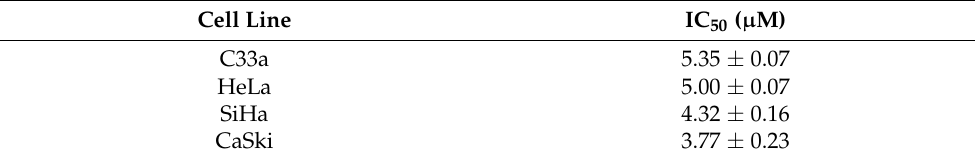
Table 1. Cell proliferation IC 50 values of AM in cervical cell lines bearing different HPV viral load.